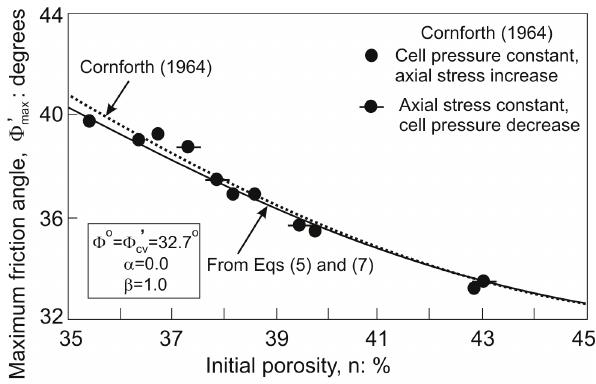
Fig. 3. Relationship between and the strain increment ratio at failure for Ham River sand